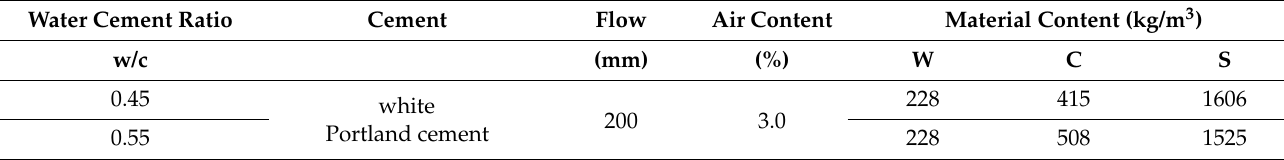
Table 1. Mix proportions of